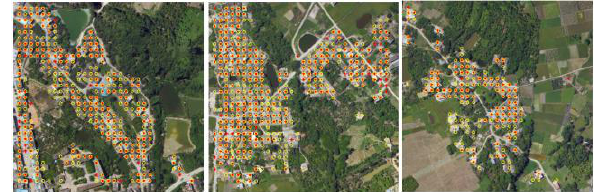
Figure 6. The intersection output of the building detection